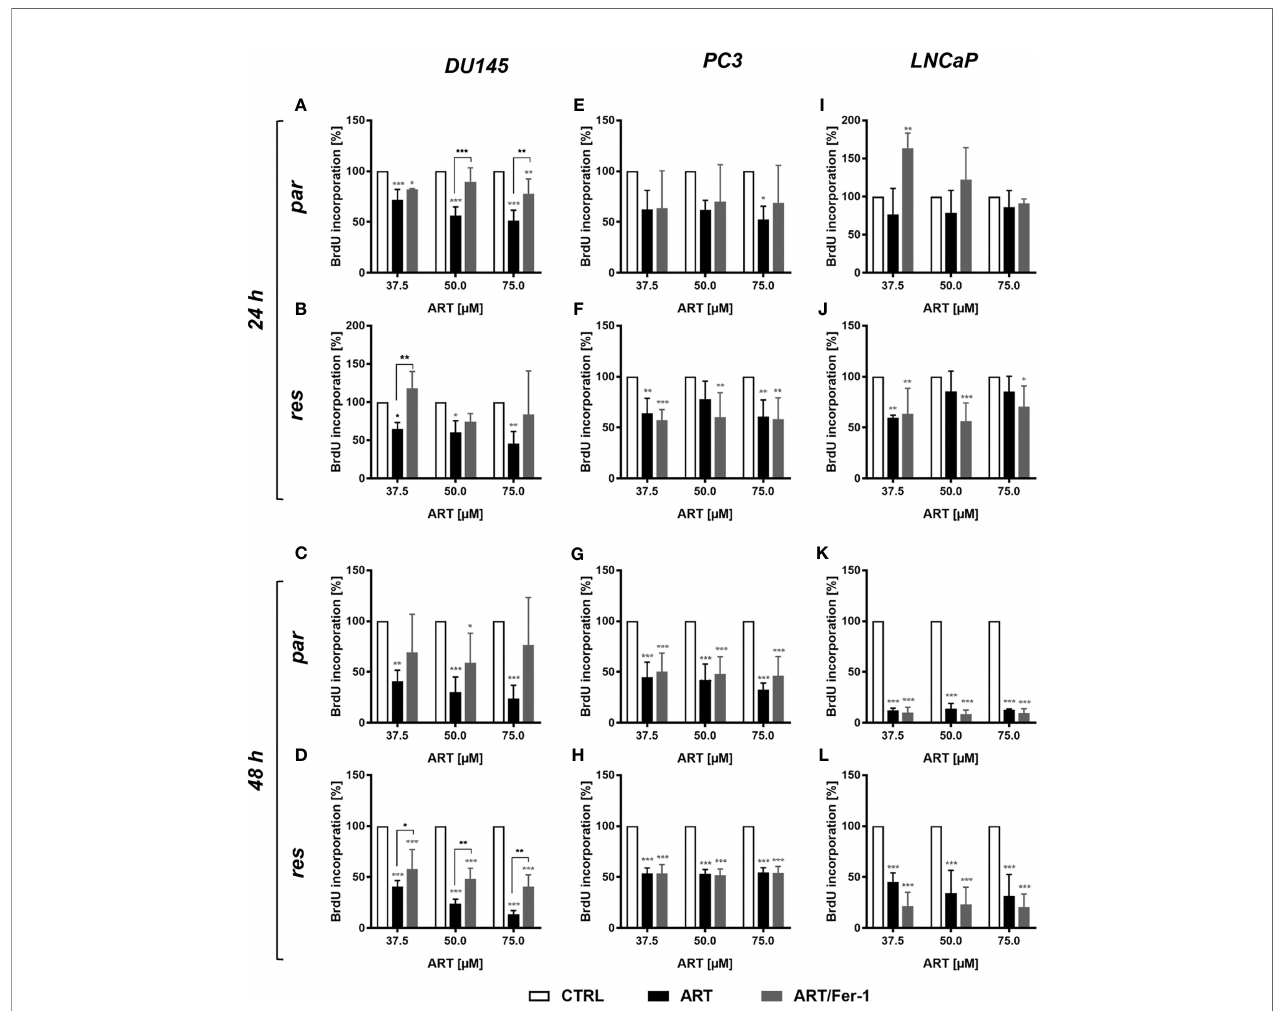
FIGURE 7 | Ferroptosis induction: cell proliferation of parental (par) and DX-resistant (res) DU145, PC3, and LNCaP cells treated for 24 (A, B, E, F, I, J) and 48 h (C, D, G, H, K, L) with ART [37.5 - 75 µM], alone or in combination with ferrostatin-1 (Fer-1) [20 µM]. Untreated cells (100%) served as controls. Error bars indicate standard deviation (SD). Asterisk brackets indicate signi fi cant difference between ART and ART with ferrostatin-1 treatment. Signi fi cant difference compared to untreated controls indicated by: *p ≤ .05, **p ≤ .01, ***p ≤ .001. n =